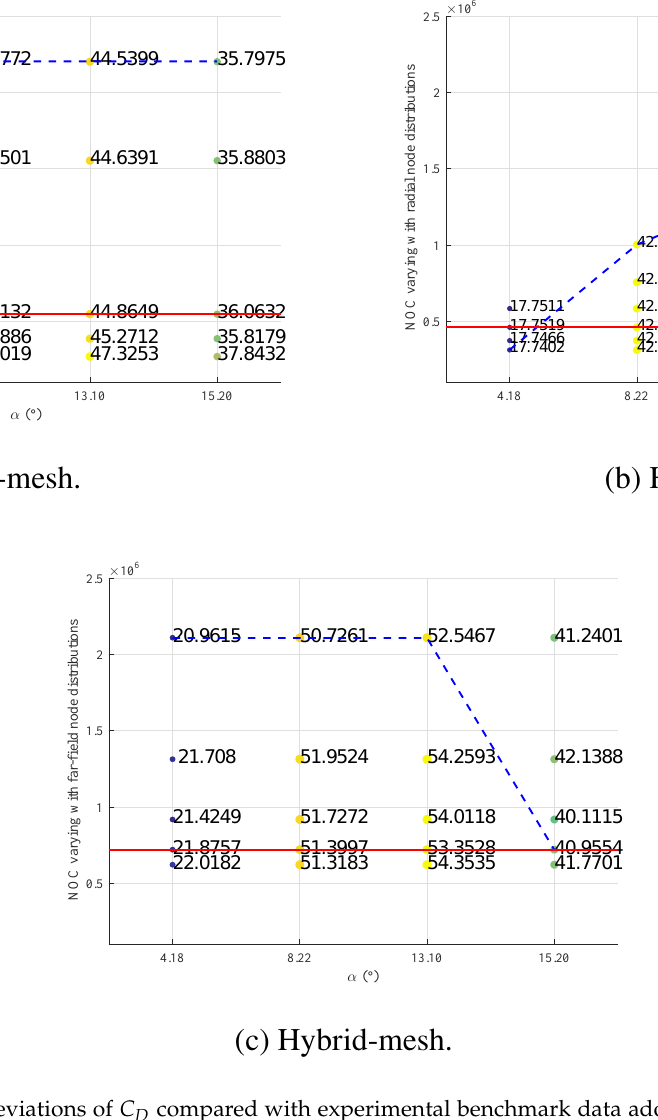
Figure 19. Calculation deviations of C D compared with experimental benchmark data adopted from [25] varying with numbers of cells, while changing radial node distributions in near-field (blue dotted lines connect minimum errors under each α and red lines mark selected mesh settings for each